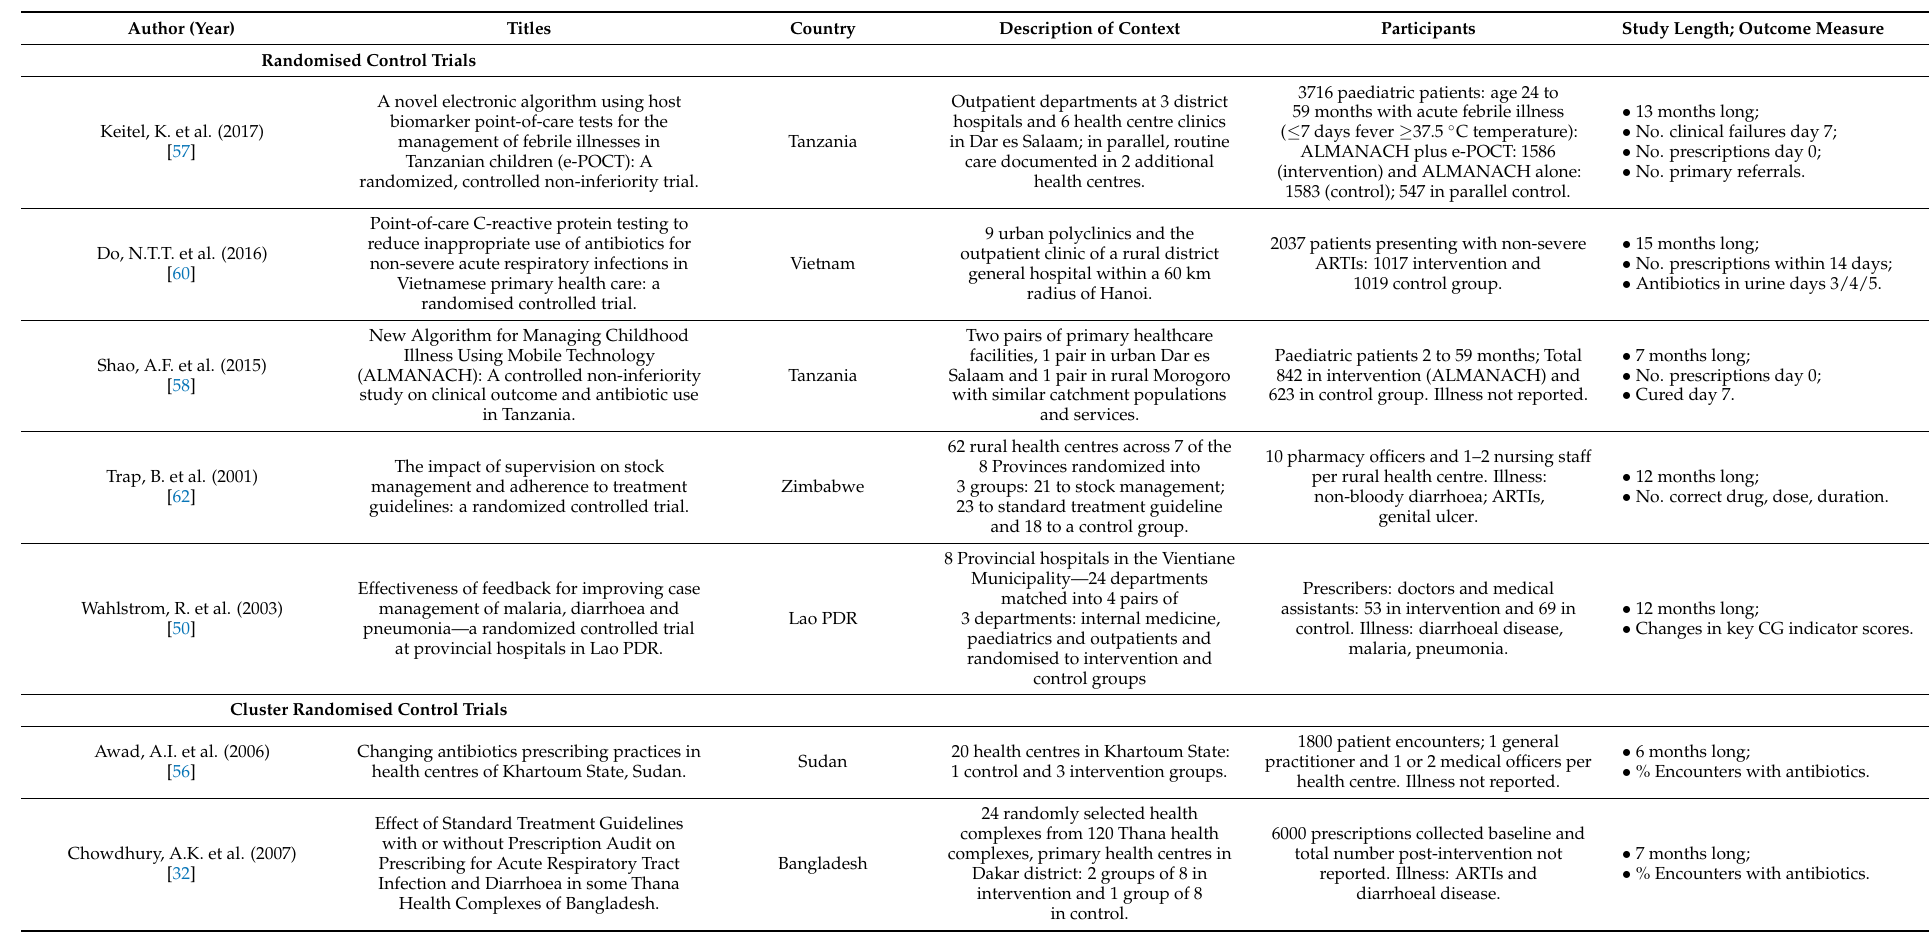
Table 1. Description of studies included in systematic review investigating strategies for implementing and promoting adherence to antibiotic guidelines in